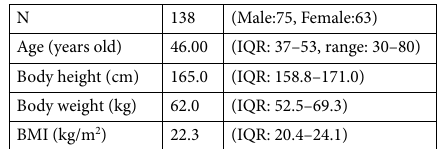
Table 1. Volunteer characteristics (n =